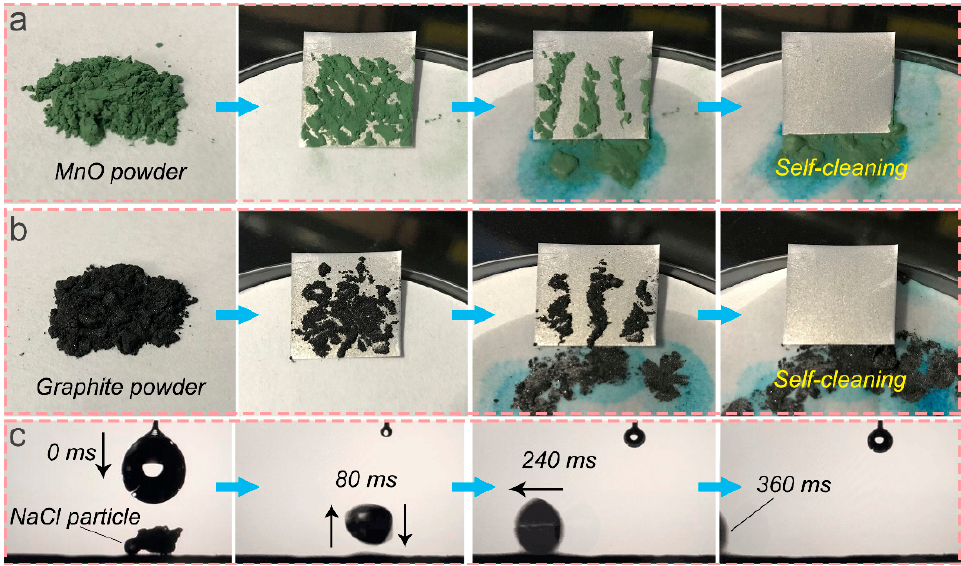
Figure 6. Self-cleaning ability with different surface contaminations: ( a ) MnO powder, ( b ) graphite powder, and ( c ) NaCl self-propelling property.